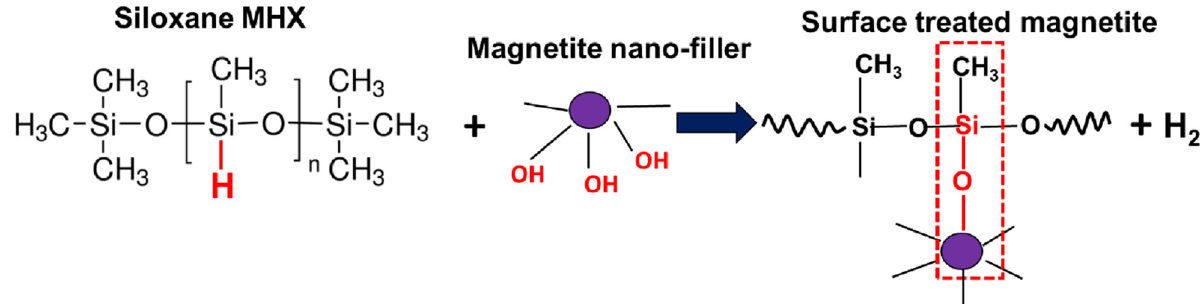
Scheme 1. Schematic illustration of the reaction mechanism between polymethylhydrogensiloxane (MHX) and the hydroxyl groups (–OH) present at the surface of the magnetite nanofiller.